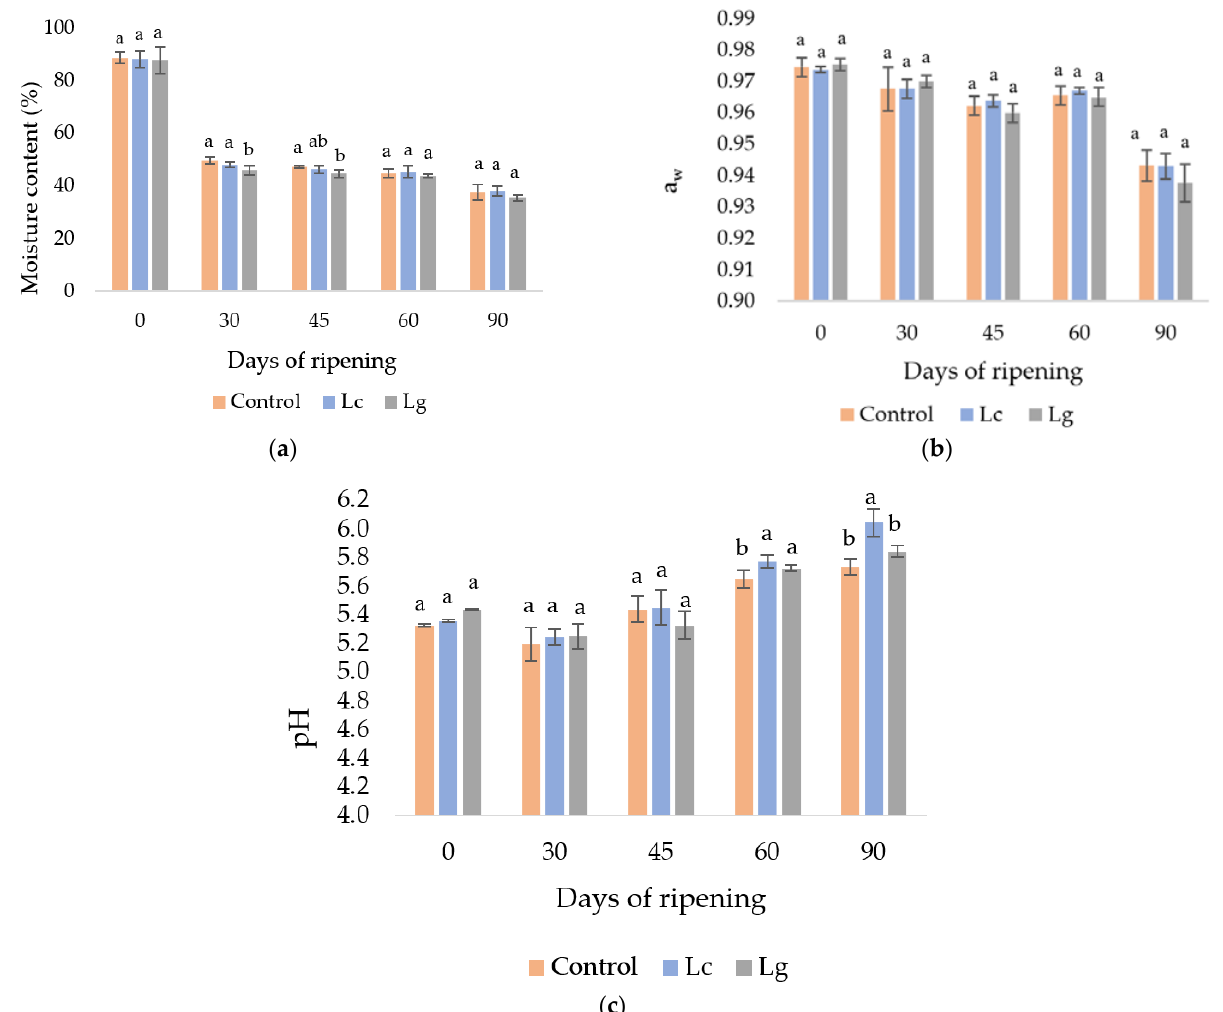
Figure 1. ( a )Evolution of moisture content; ( b ) water activity and ( c ) pH during ripening of “Torta del Casar” cheese. Mean values with different lowercase letters indicate significant differences between batches at the same incubation day. Control (uninoculated batch), Lc (inoculated with Lacticaseibacillus casei ) and Lg (inoculated with Lactococcus garvieae ).